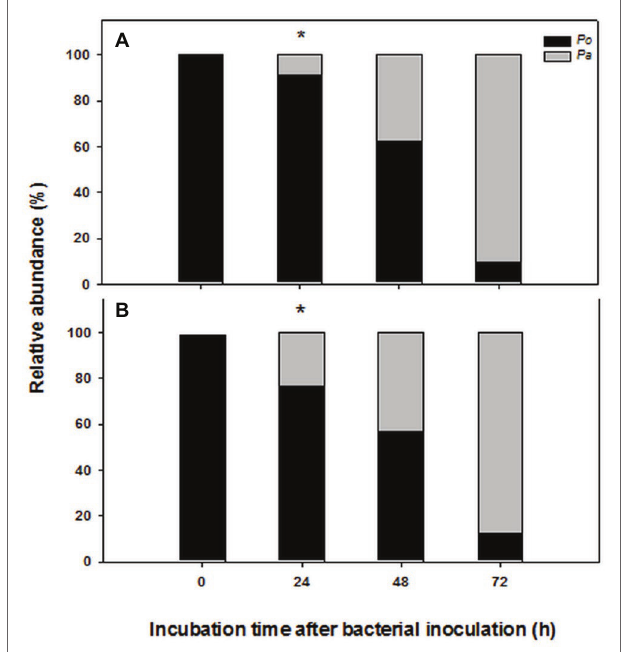
FIGURE 6 | Time-dependent changes in percent contribution of fungal (black) and bacterial (gray) biomass in mixed biofilms obtained by inoculating P. alcaliphila ( Pa ) on already established 4-day-old P. ostreatus ( Po ) biofilms and incubating for 24, 48, and 72 h at 30 ° C under orbital shaking (150 rpm). Plot (A) refers to the estimates obtained by q-PCR analysis of 16S and 18S rRNA genes, respectively while plot (B) refers to those obtained by ester- linked fatty acid methyl esters analysis. Pair-wise comparison between estimates obtained at the same incubation time with the two methods was performed by the Student’s t -test after arcsin of the square-root transformation of percent data. The presence of an asterisk above bars denotes the presence of statistically significant differences.